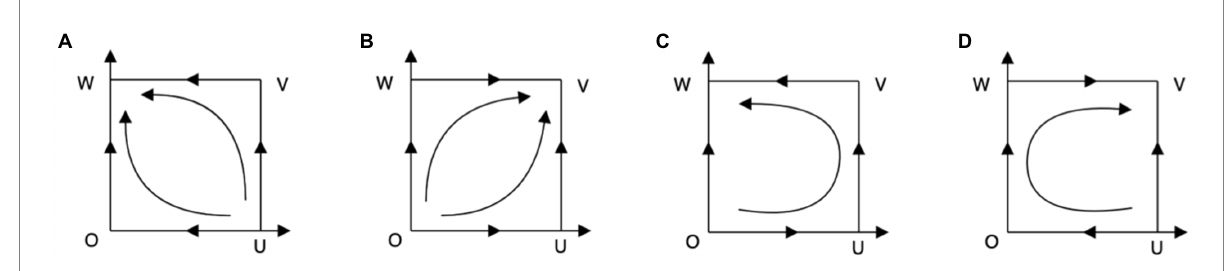
FIGURE 1 Phase diagram of system evolution when